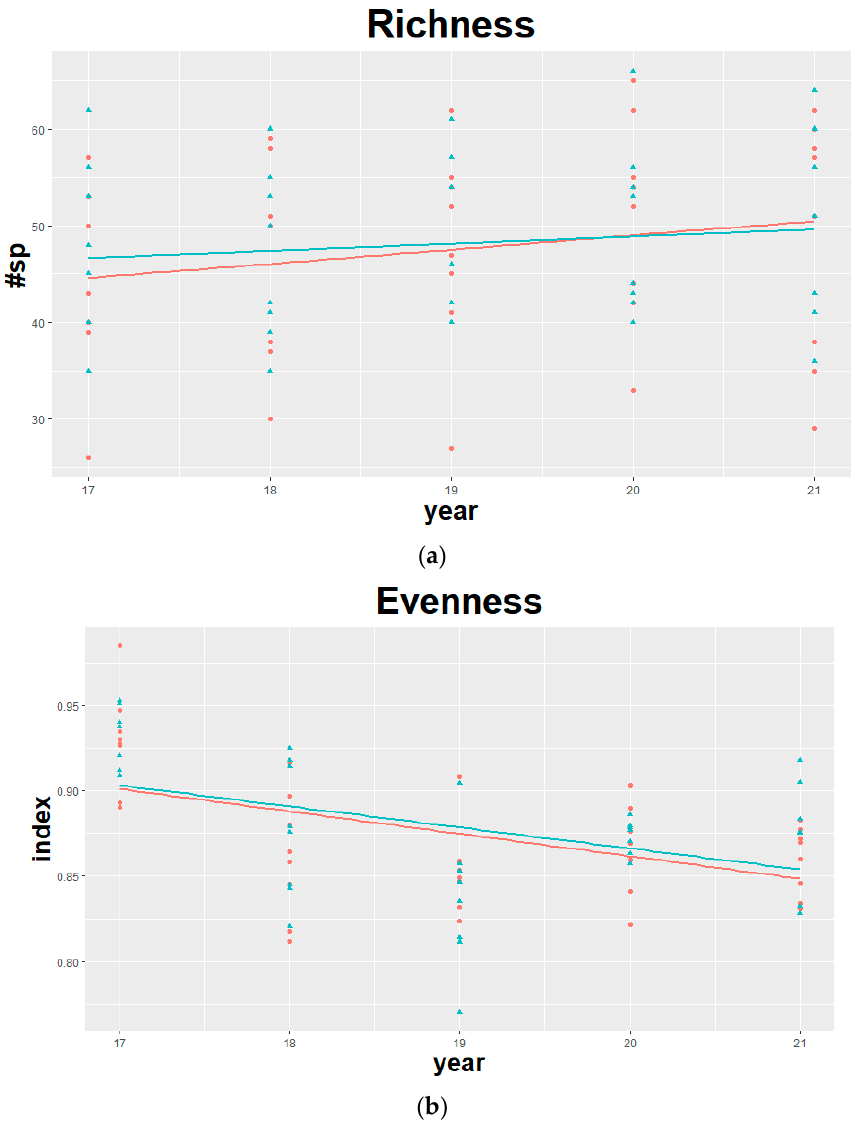
Figure 4. ( a ) Linear variation of species richness in ungrazed and grazed plots. Blue lines and dots for control and red for exclusion plots. ( b ) Same presentation of the Smith and Wilson Evenness Index.